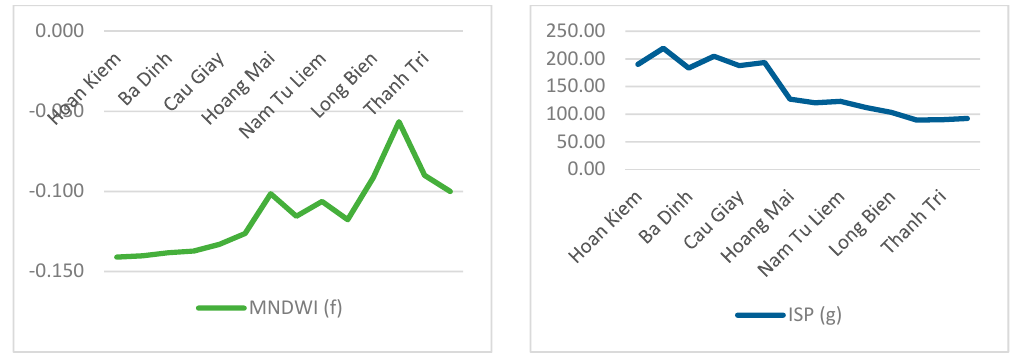
Figure 8. The median values of the spatial factors for each district.